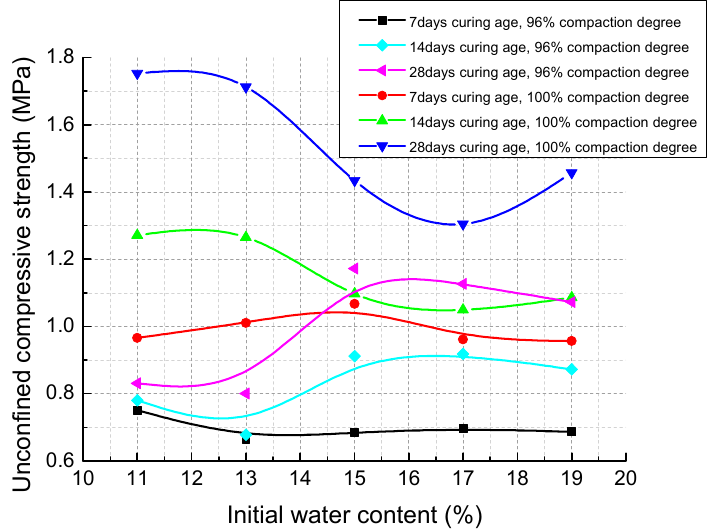
Figure 11. Effects of initial water content on unconfined compressive strength of specimens cured in moist air.